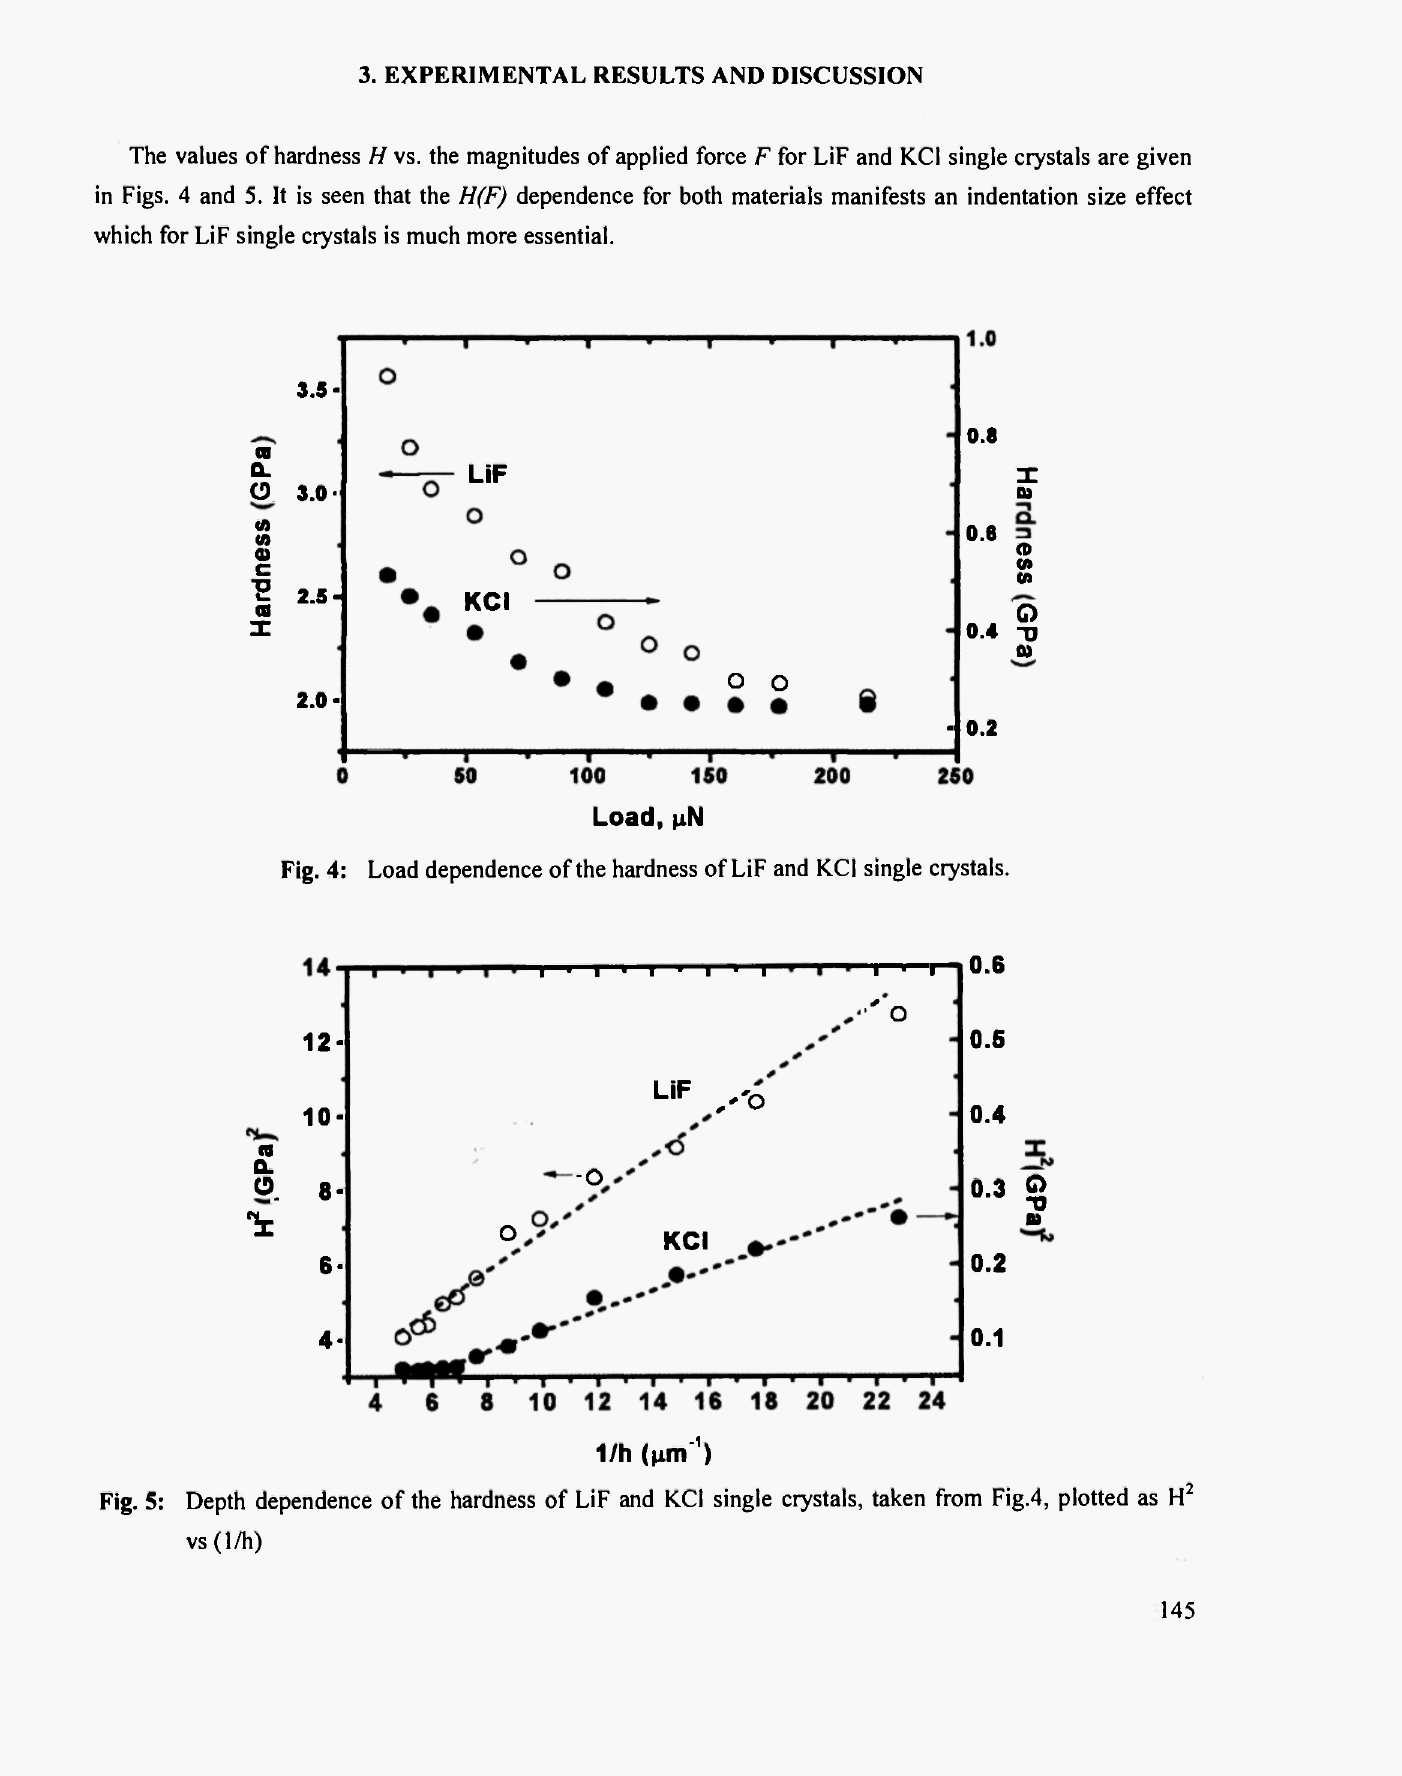
Fig. 5: Depth dependence of the hardness of LiF and KCl single crystals, taken from Fig.4, plotted as H 2